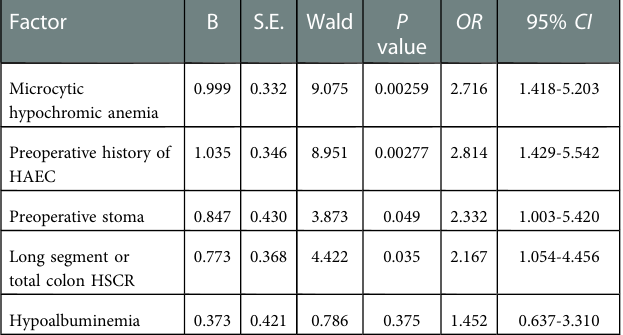
TABLE 4 Logistic multivariate analysis of postoperative HAEC in children with HSCR.